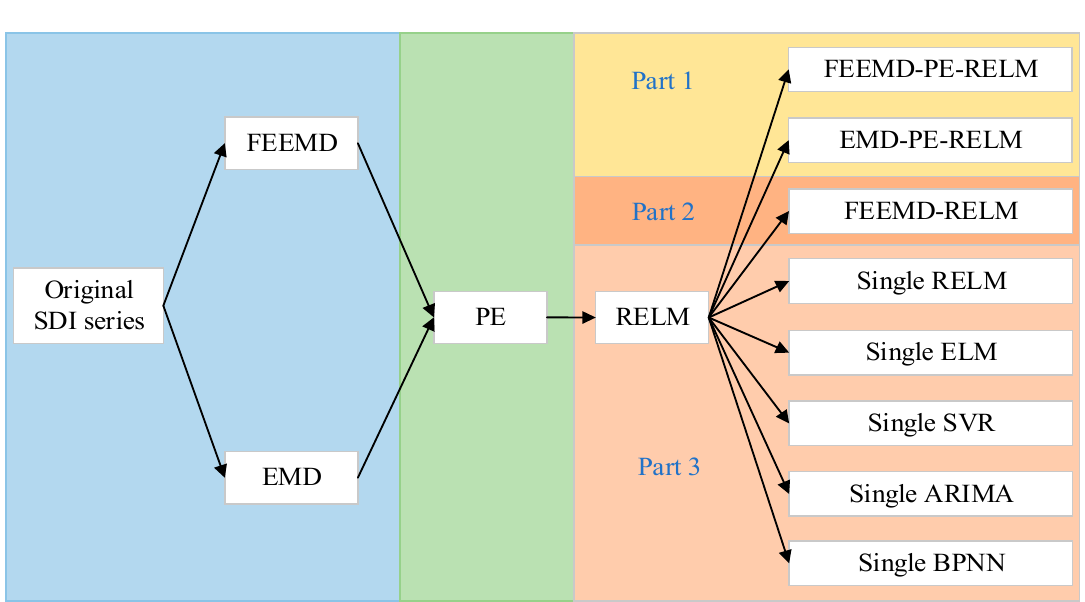
Figure 7. Refactored IMFS (RIMFs) from fast ensemble empirical mode decomposition (FEEMD) decomposition results.